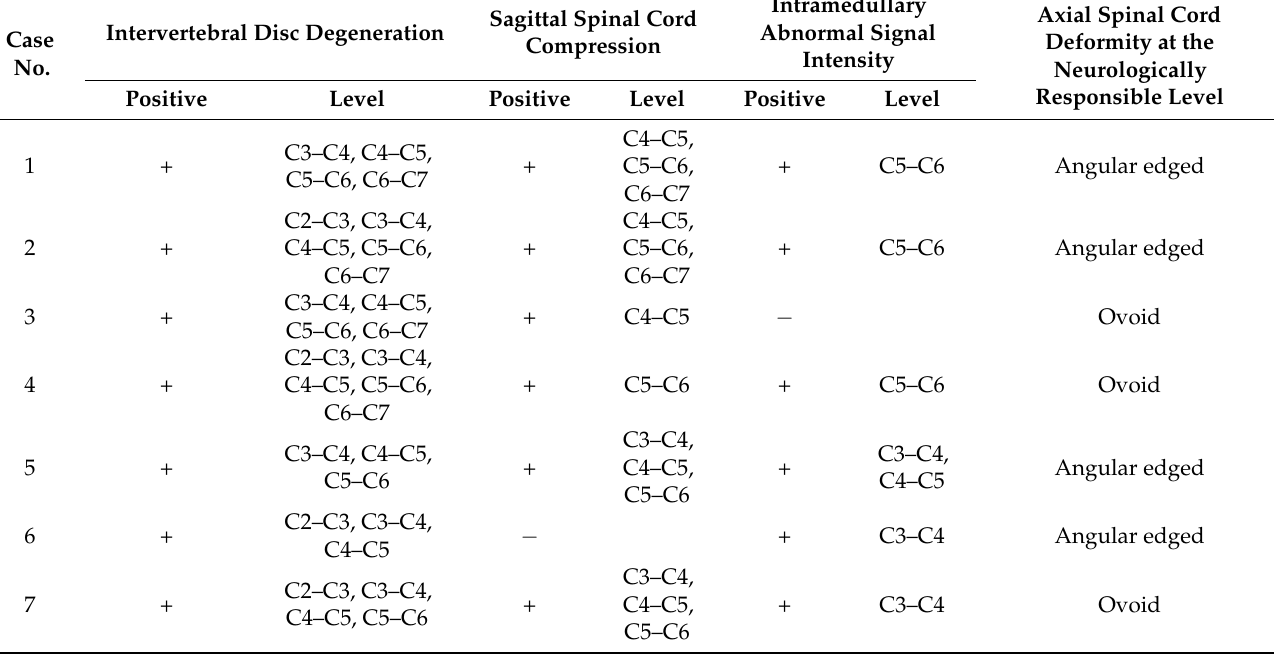
Table 3. Magnetic resonance imaging characteristics of young adult patients with cervical spondylotic myelopathy under age